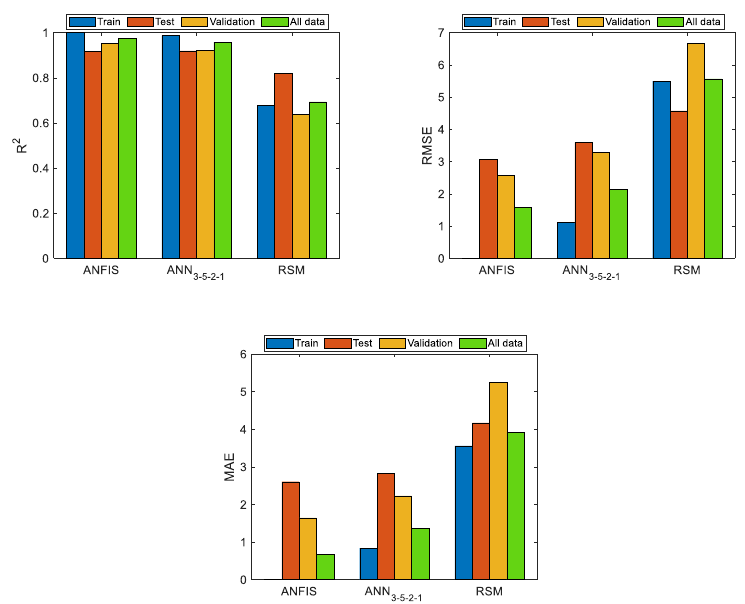
Figure 35. Validation metrics for the (ANFIS, ANN 3-5-2-1 , Regression) models. Type 2 function (EW). The data for obtaining these graphs have been taken from Ref. [61]).